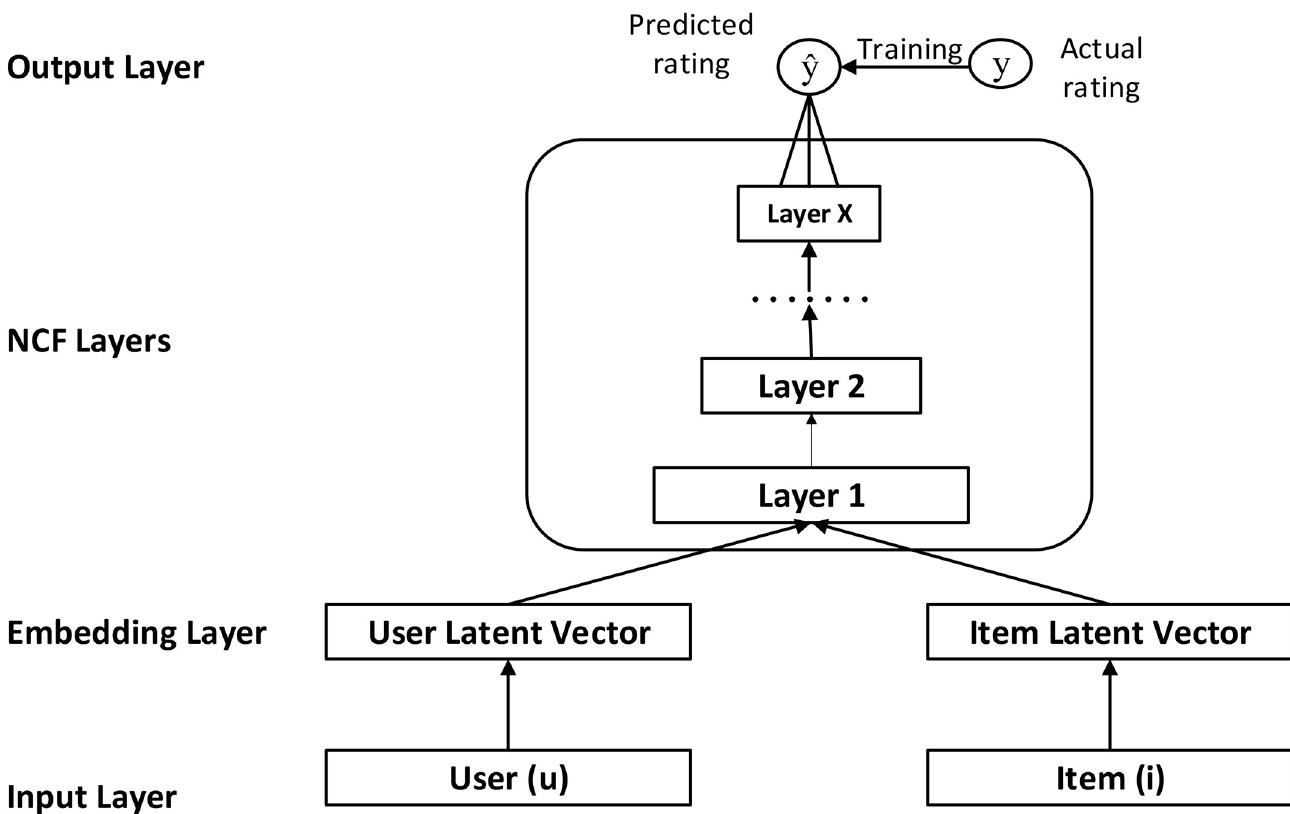
Fig 3. Neural Collaborative